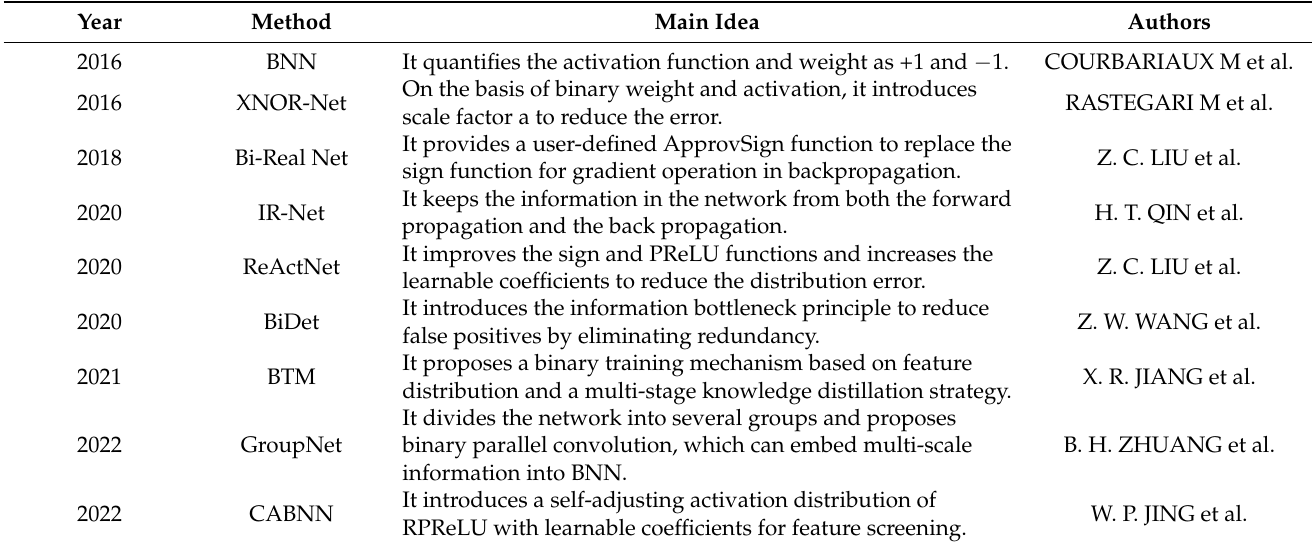
Table 1. Previous work of binary neural network